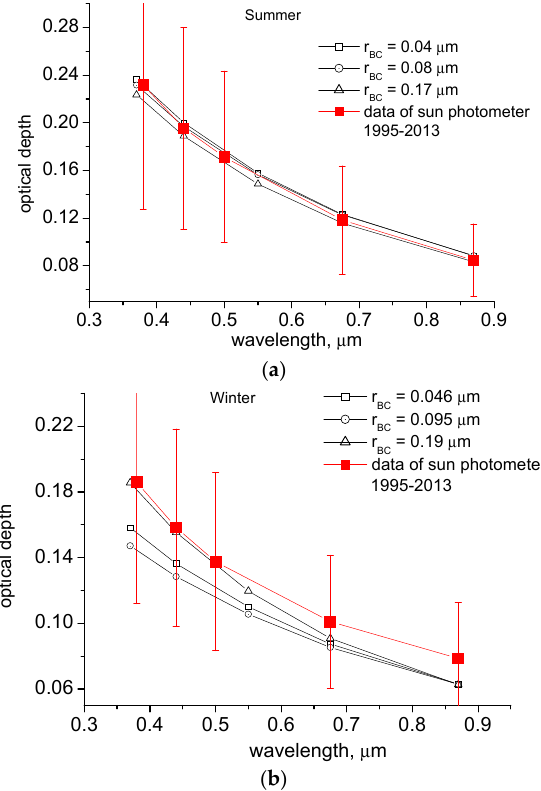
Figure 5. Comparison of the values of aerosol optical depth (AOD) computed using the presented model with the results of sun-photometer measurements in Tomsk in 1995–2013 in summer ( a ) and winter ( b ) [27,28].